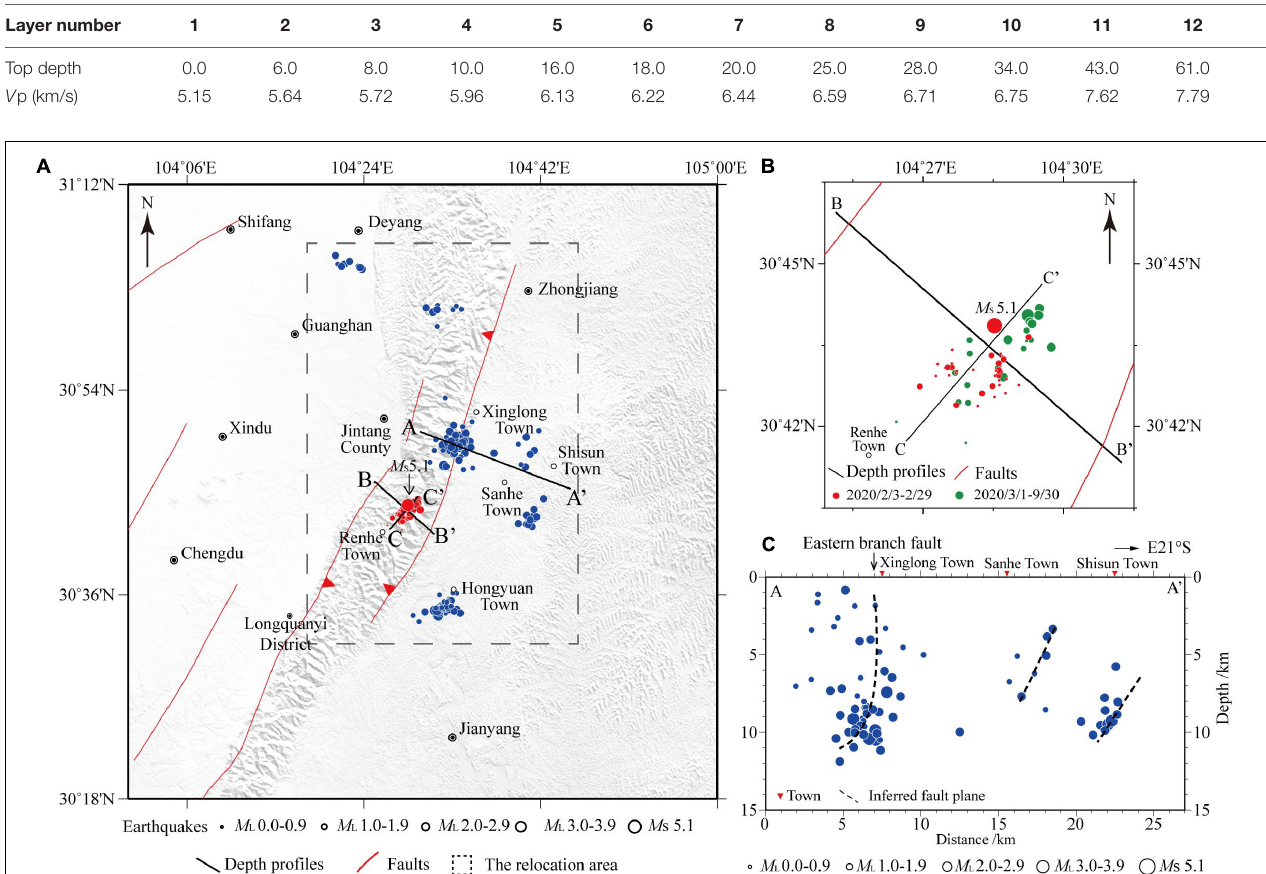
TABLE 1 | One-dimensional velocity model in the Longquanshan area.